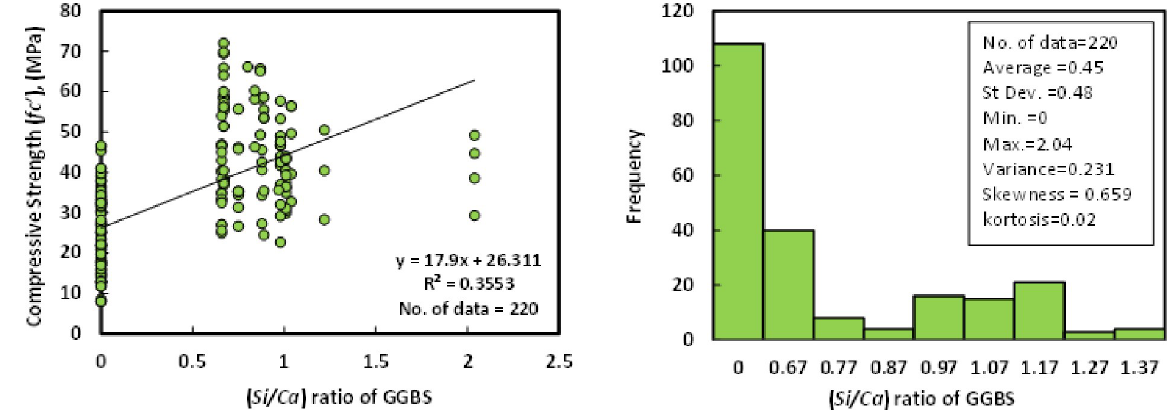
Fig 6. Relationship and a histogram of compression strength and curing duration of GGBS/FA-GPC.